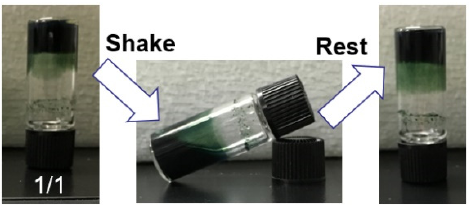
Figure 3. Photos of thixotropic behavior of 1.0 wt% NaPPDT /1.0 wt% PAPA aq. 1/1 ( w / w ) in a vial: ( left ) before shaking (gel state), ( center ) immediately after shaking (sol state), and ( right ) after resting for 1 min.